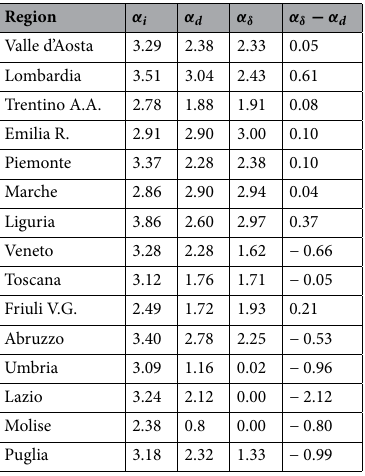
Table 4. Extracted scaling exponents by region, for cumulative infections ( α i ); cumulative COVID-19 deaths ( α d ); cumulative increase of deaths in 2020 ( α δ ) and difference between α δ and α d